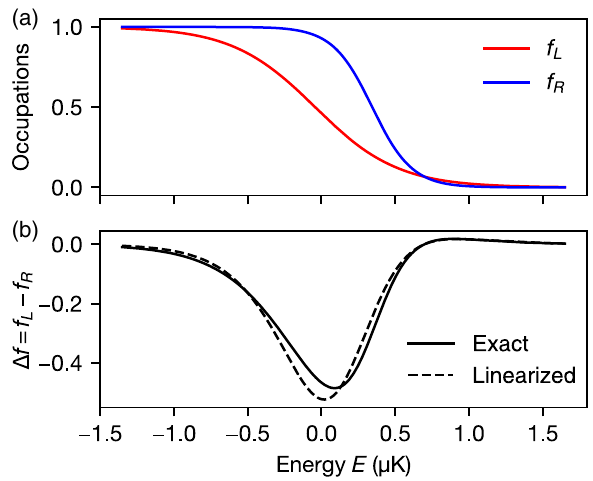
FIG. 9. Validity of linear response. (a) Fermi-Dirac distribu- tions in both reservoirs as prepared for the noninteracting measurement and (b) their exact (solid) and linearized (dashed) difference. The numbers used are summarized in Table